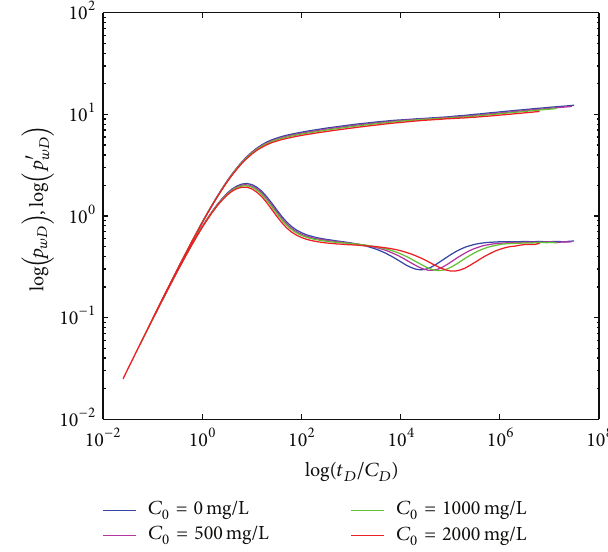
Figure 7: Effect of storativity ratio ( 𝜔 ) on type curves. after the crossflow segment ends, indicating systematic radial flow section (V).